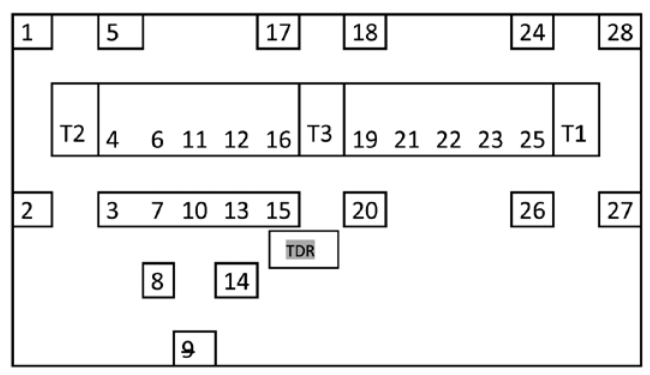
Fig. 1 - Distribution of access tubes for neutron probe measurements taking into account root distribution, soil humectation and soil coverage. Tubes were set around three olive trees of cultivar Chétoui at 1.5 m depth at distances of 1.4 m, 2.2 m, 2.8 m and 4.2 m from